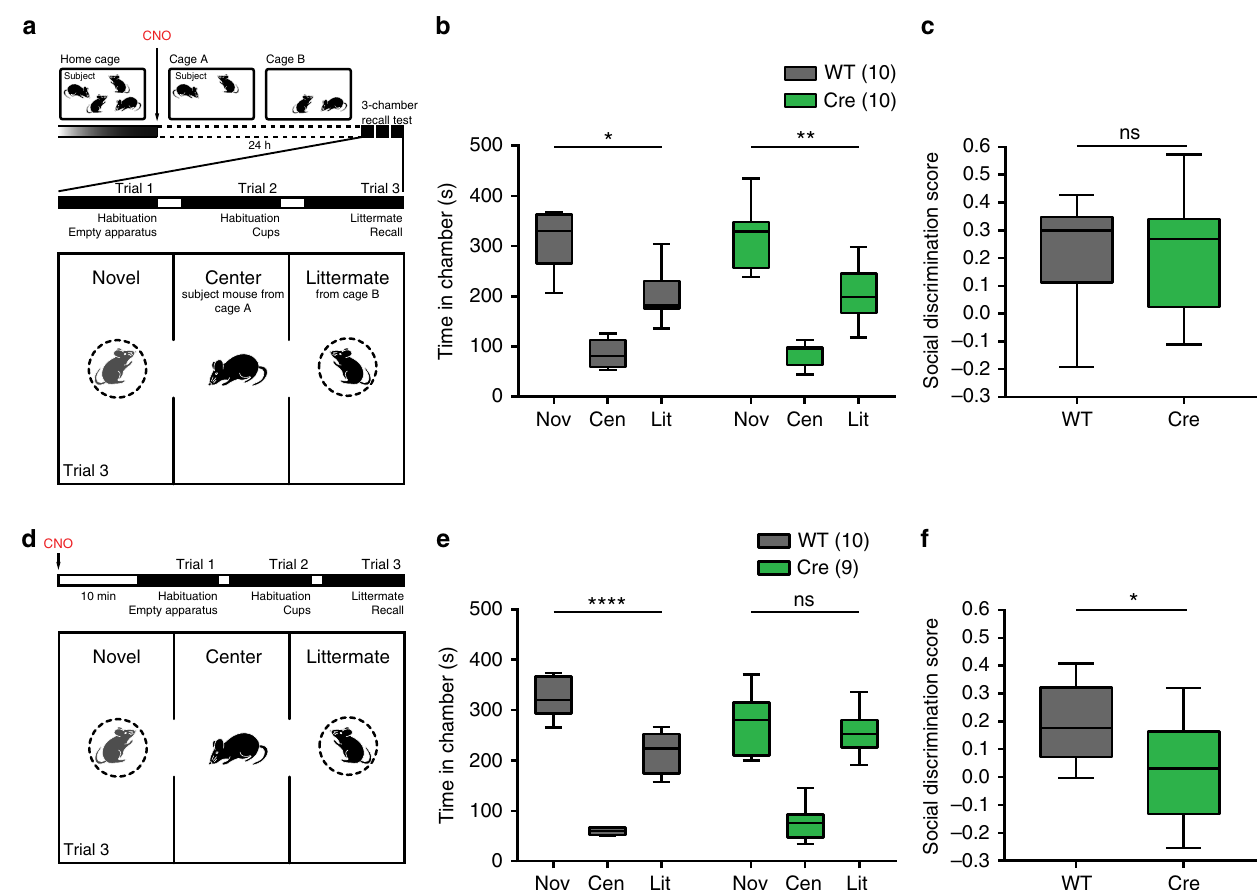
Fig. 4 dCA2 silencing does not disrupt a well-consolidated memory of a littermate but prevents its recall. a Protocol testing effect of dCA2 silencing on retention of a well-consolidated social memory. WT and Amigo2 -Cre mice were injected with AAV-DIO-hM4Di-IRES-mCitrine in dCA2. Mice were given CNO IP and randomly divided into two housing cages (A and B). After 24 h, subject mice from cage A were presented with a novel (Nov) mouse and a littermate (Lit) from cage B. b WT and Amigo2 -Cre mice spent more time in the chamber housing the novel animal (WT repeated measures one-way ANOVA: n = 10, F (1.414, 12.73) = 44.89, P < 0.0001, Novel vs Littermate P = 0.0114, Tukey ’ s multiple comparisons test; Cre repeated measures one-way ANOVA: n = 12, F (1.253, 13.79) = 50.15, P < 0.0001, Novel vs Littermate P = 0.0086, Tukey ’ s multiple comparisons test). The groups did not differ signi fi cantly (two-way ANOVA: treatment × chamber F (2,40) = 0.006505, P = 0.9935). c WT and Amigo2 -Cre mice showed similar social discrimination scores (unpaired t test: t (20) = 0.03401, P = 0.9732). d Experimental protocol silencing dCA2 during social memory recall. WT and Amigo2 -Cre